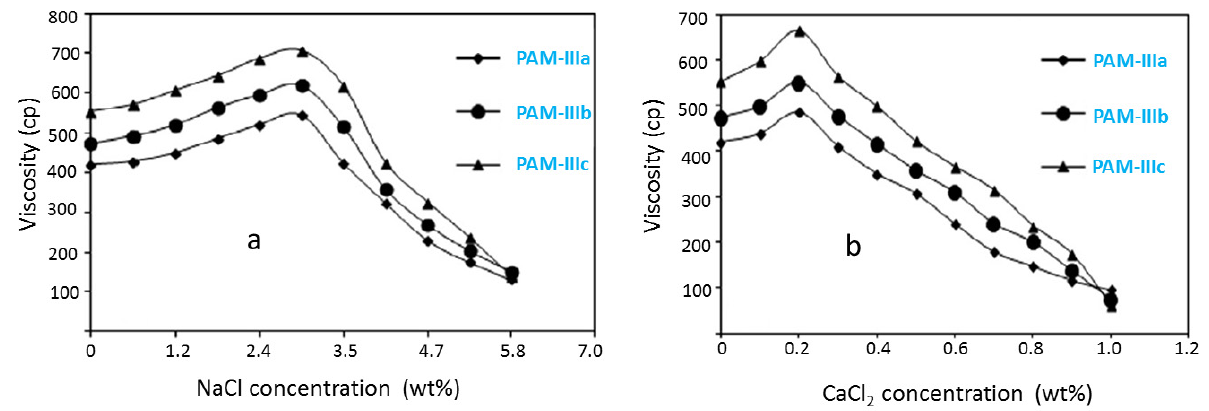
Figure 5. Effects of ( a ) NaCl and ( b ) CaCl 2 concentration on the viscosity of hydrophobically modified polyacrylamides at 30 °C. Adapted with permission from [221].